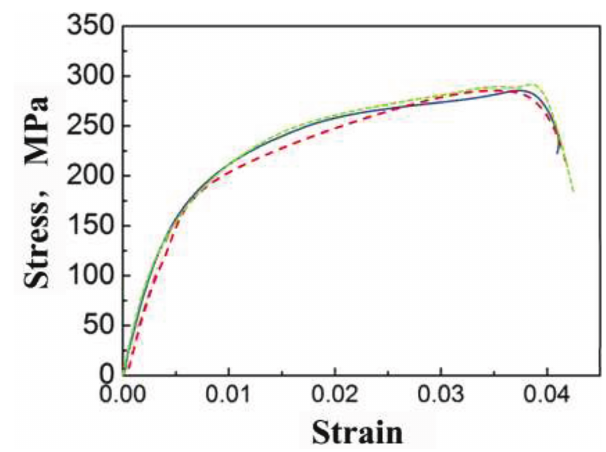
Figure 10: Nominal stress-strain curves of the DWMW joints.